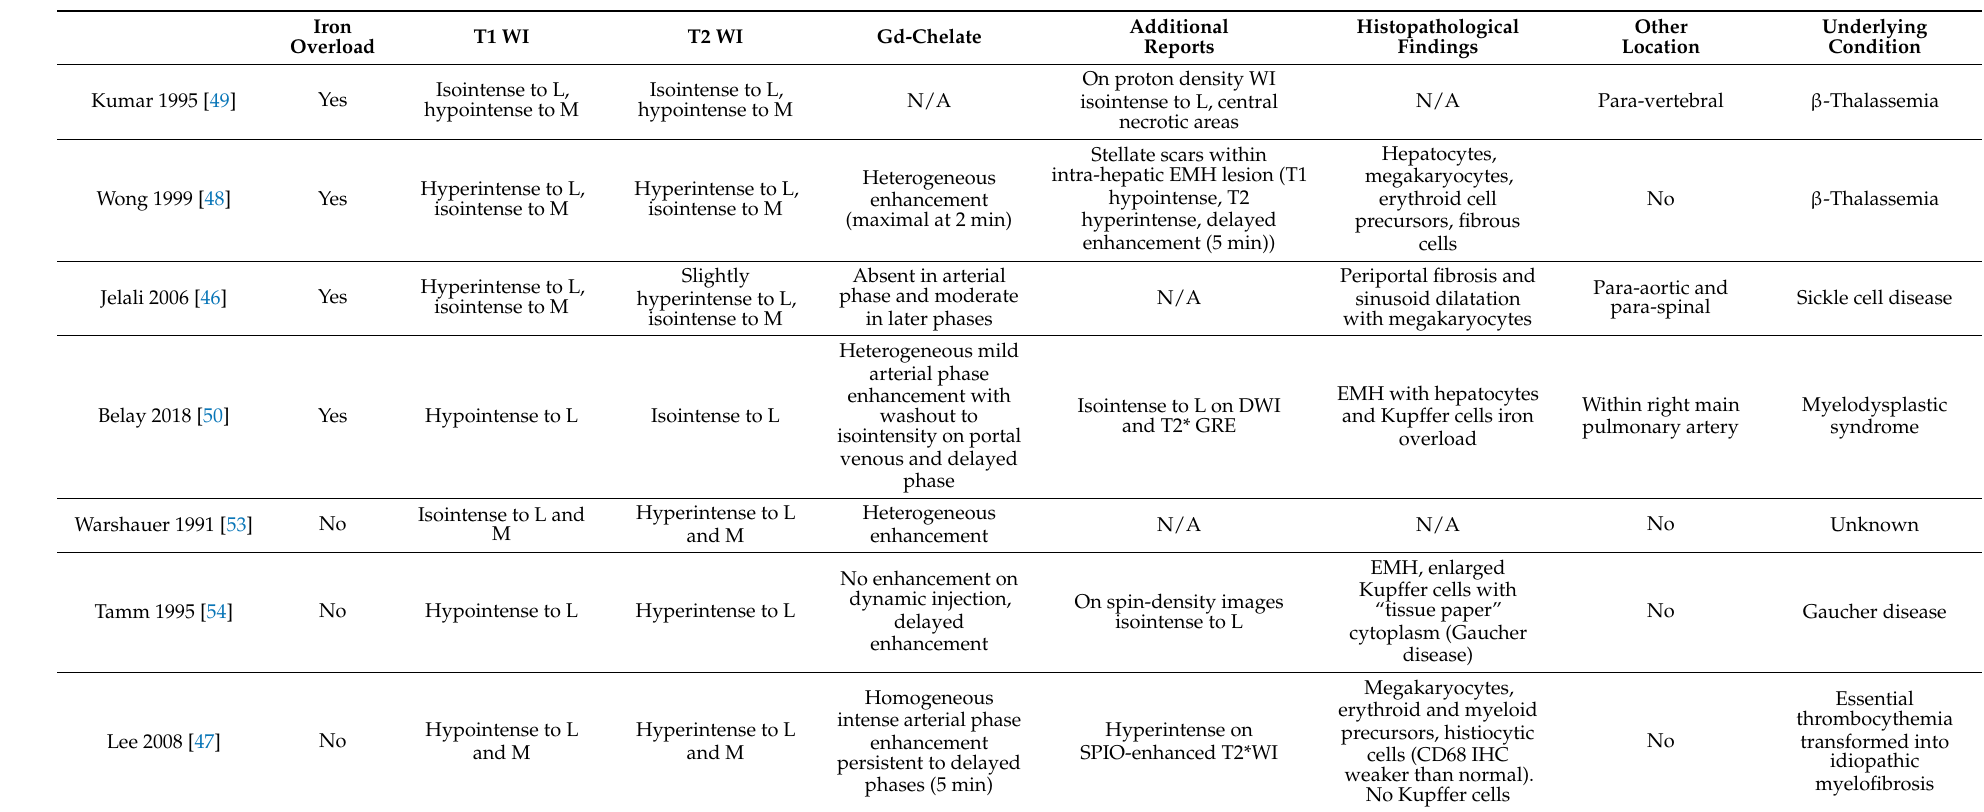
Table 2. Focal intra-hepatic extra-medullary hematopoiesis: review of the